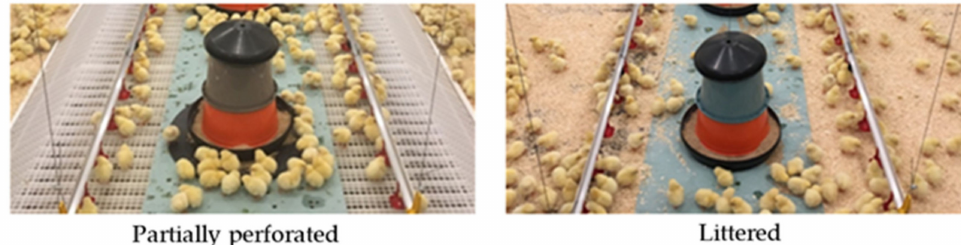
Figure 1. Illustration of the partially perforated flooring system, with an elevated perforated area in the section of feed and water supply, and the littered flooring